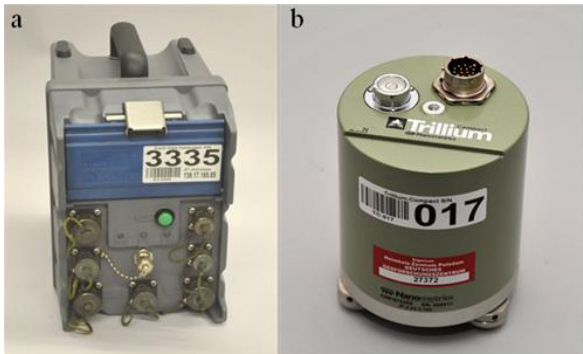
Figure 3. Broadband portable seismic stations deployed during the experiment. (a) EarthData PR6-24 three-channel recorder, and (b) Trillium Compact broadband three-component sensor.